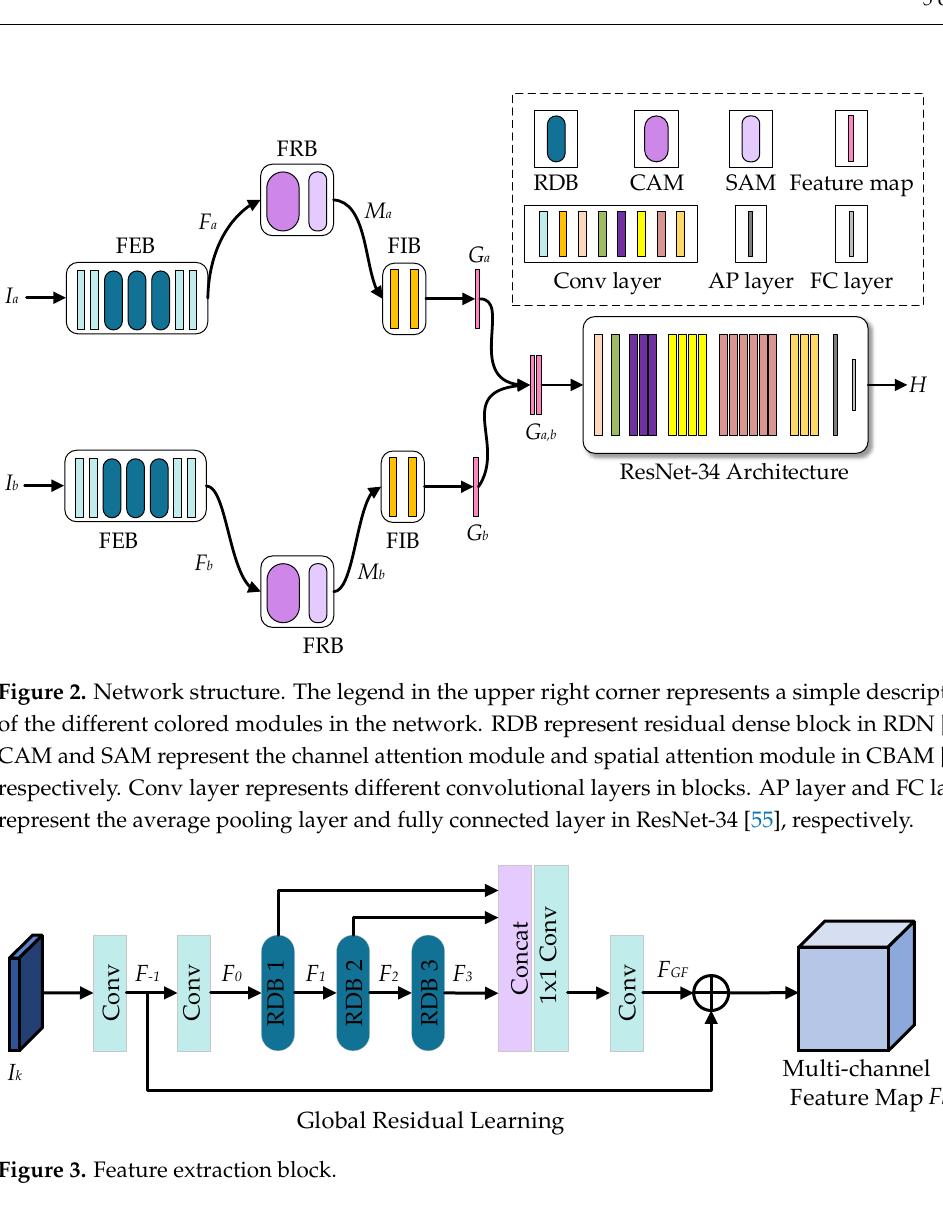
Figure 3. Feature extraction block.